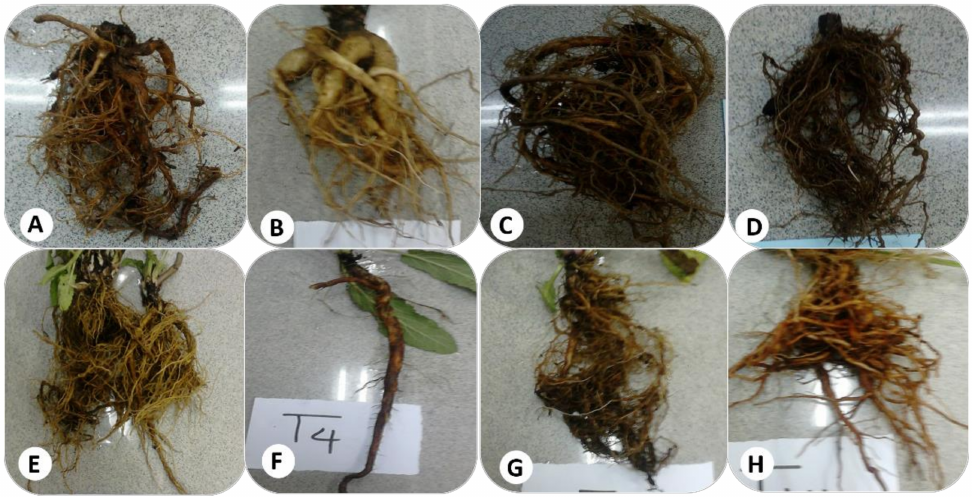
Figure 2. Root system of five-month-old Salvia species. ( A ), S. atropatana ; ( B ), S. macrosiphon ; ( C ), S. sclarea ; ( D ), S. officinalis ; ( E ), S. nemorosa ; ( F ), S. syriaca ; ( G ), S. virgata ; ( H ), S. frigida